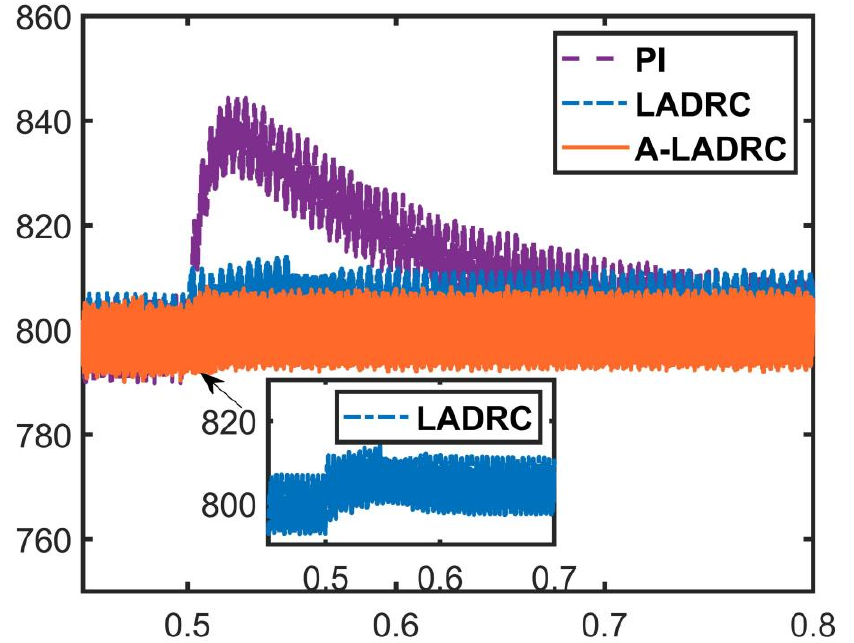
Figure 14. DC bus voltage waveform in case of fault.